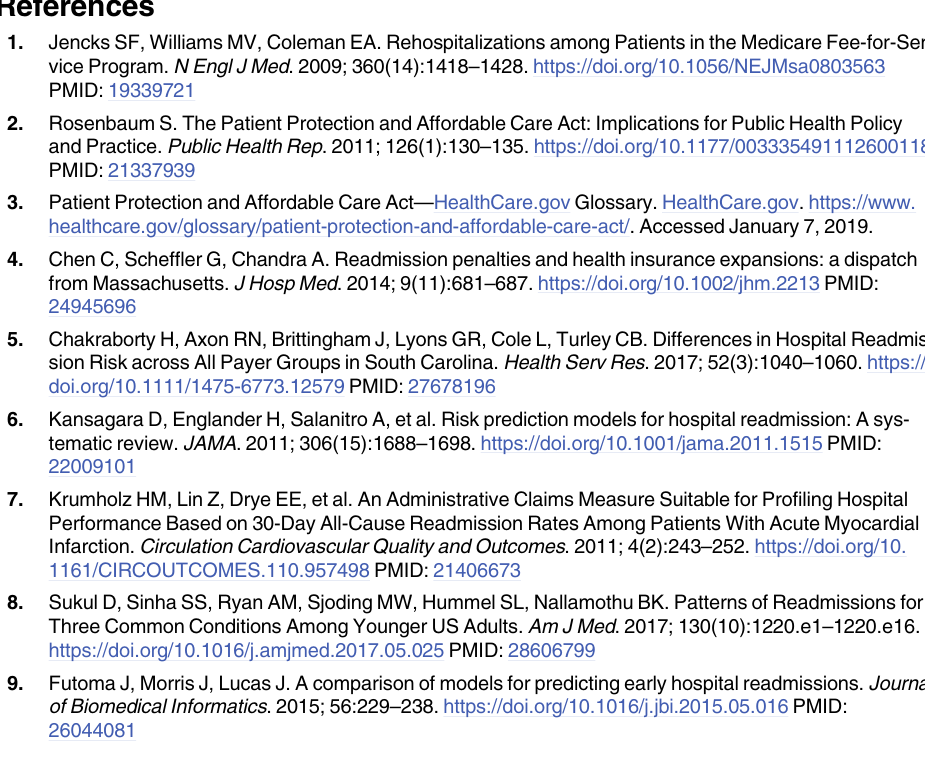
S1 Table. Summary statistics of ICD-9CM diagnosis and procedure codes for each